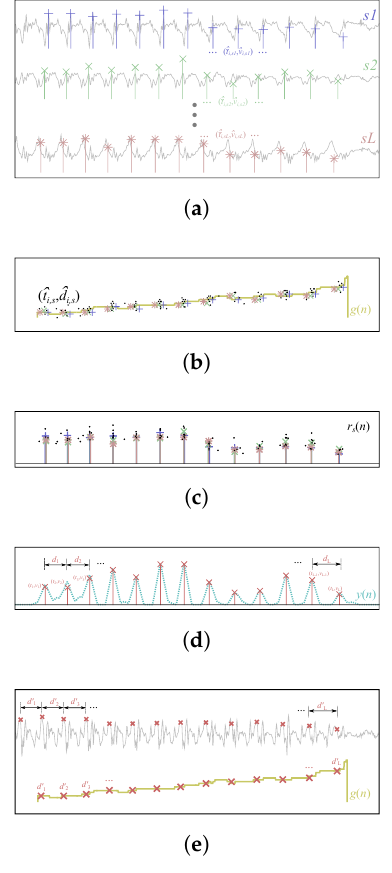
Figure 1. Pipeline of the proposed stride segmentation approach. ( a ) Component-wise local cyclicity estimation; ( b ) Assessment of stride positions; ( c ) Alignment of assessed stride positions; ( d ) Fusion of aligned stride positions; ( e ) Enhancement of assessed stride positions on the reference